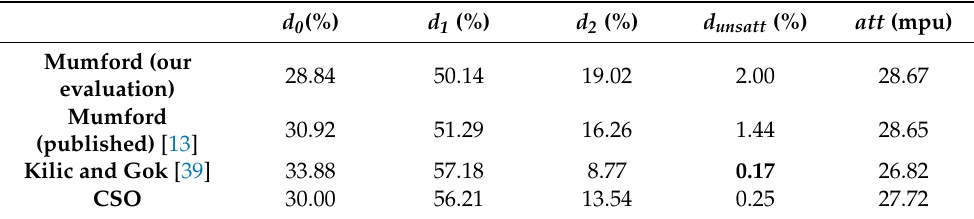
Table 15. Comparative results for the best solutions for Mumford2